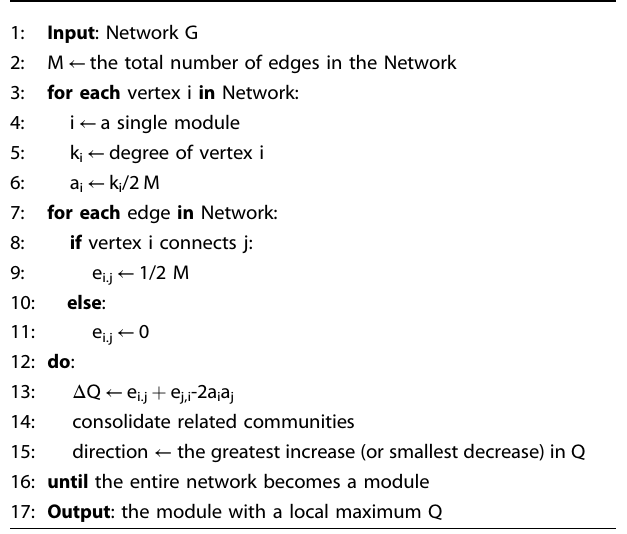
Algorithm 2 . Module detection algorithm.